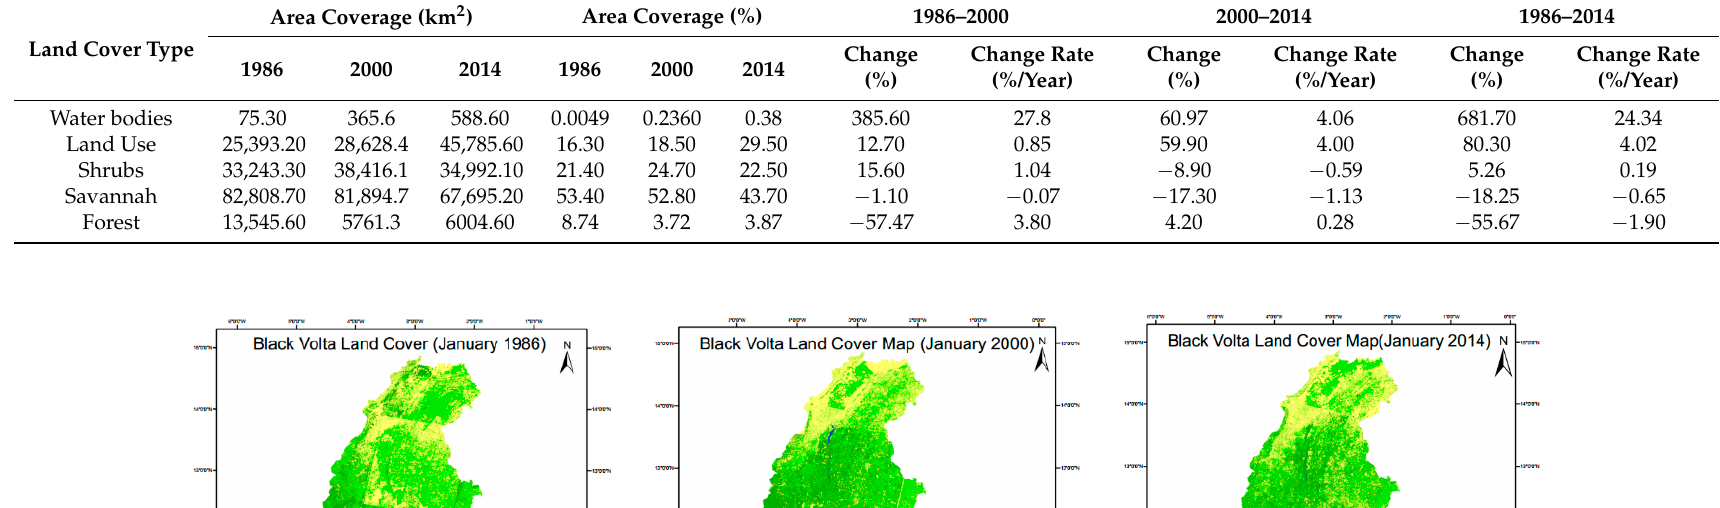
Table 1. LULC characteristics.